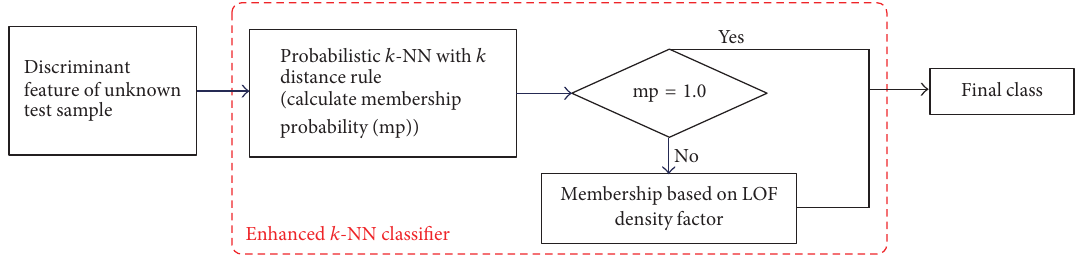
Figure 6: The proposed 𝑘 -NN classifier.